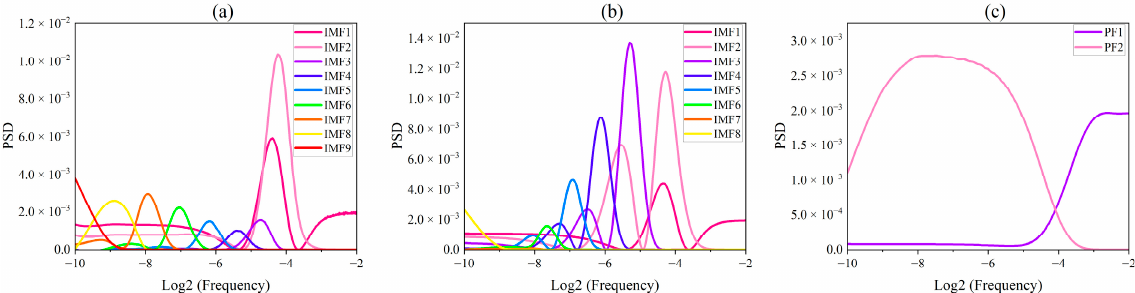
Figure 1. Decomposition results of (Setting the same noise standard deviation parameter and ensemble number parameter in three methods).